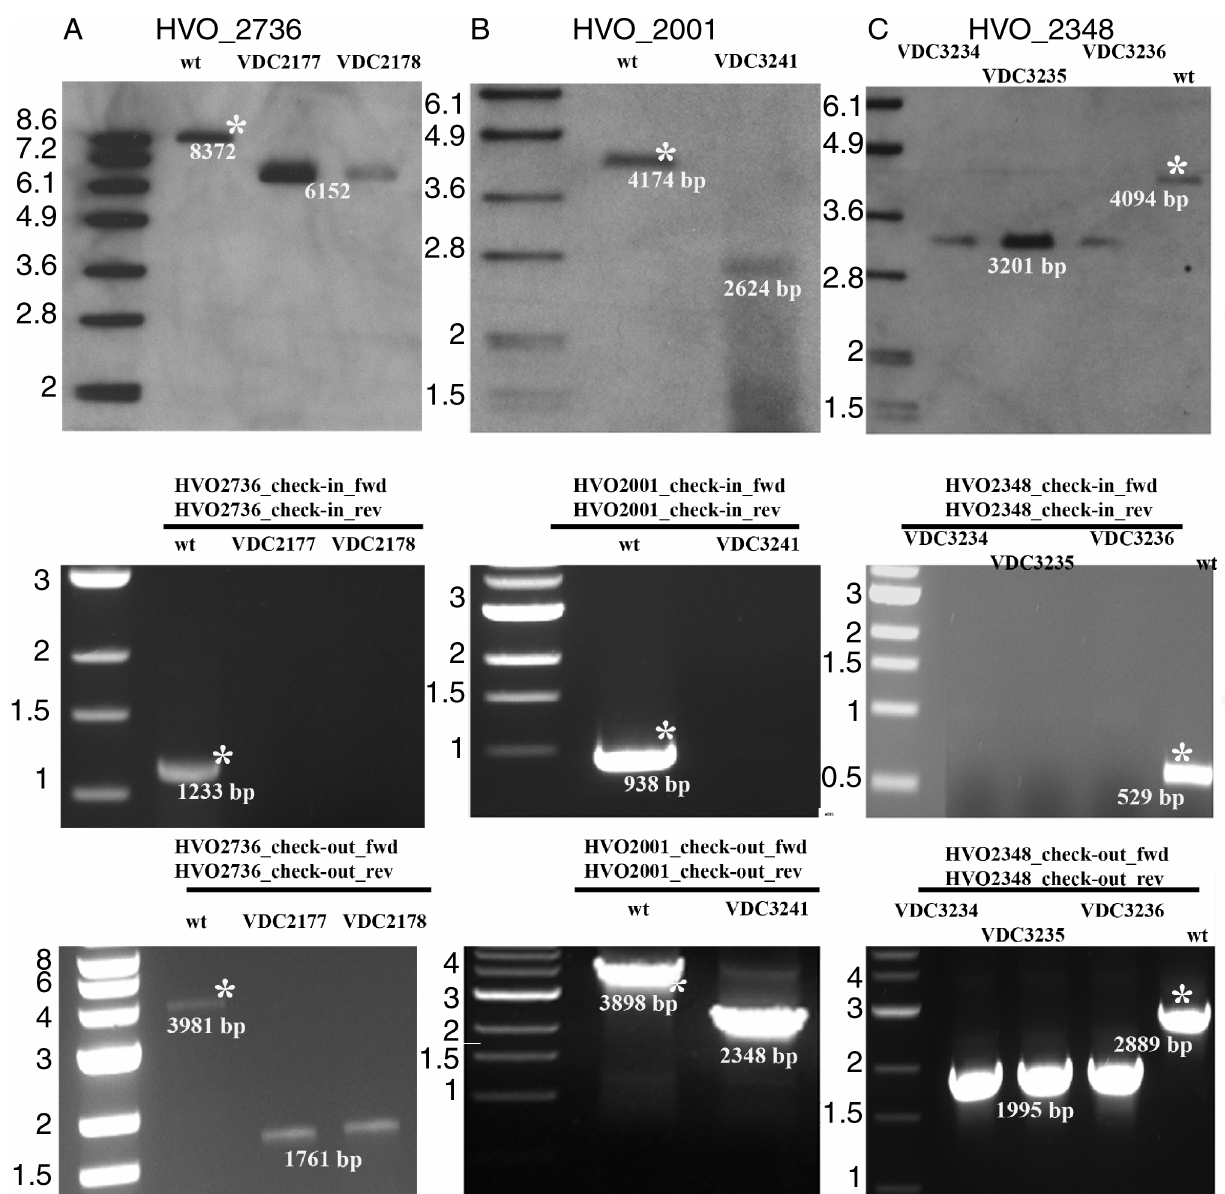
Figure 2. Southern blot analyses and PCR verifications of the three H. volcanii mutants constructed. Deletion strain for HVO_2736 (A), deletion strain for HVO_2001 (B) and deletion strain for HVO_2348 (C). Upper panels are Southern hybridization profiles, middle panel are inside prim- ers PCR checks and lower panels are outside primers PCR checks. Relevant DNA marker sizes (kb) are indicated on the right side of each panel and wild type bands (bp) are indicated by an asterisk ( * ), expected sizes are indicated under each